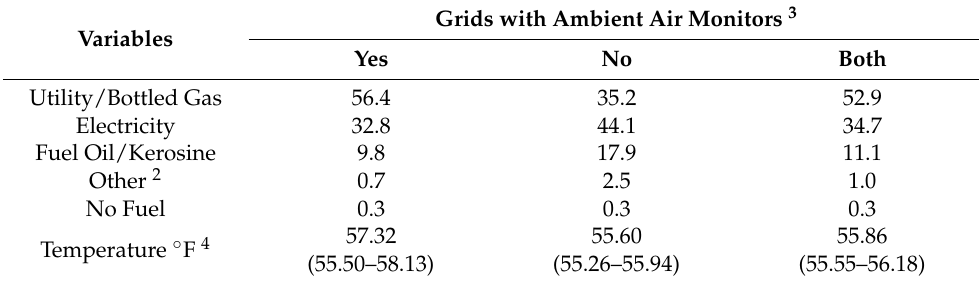
Table 9. House heating fuel used in Baltimore study area in Community Multiscale Air Quality Grids with or without ambient air monitors 1